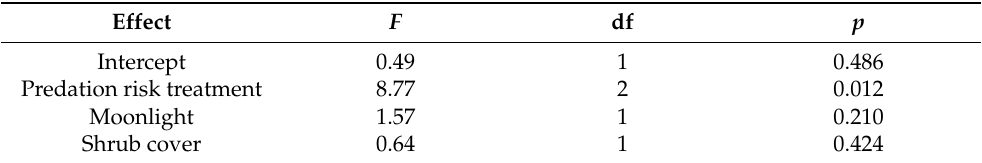
Table 11. Results of the GLM analyzing the effect of experimental and environmental factors on R. rattus slow locomotor activity.